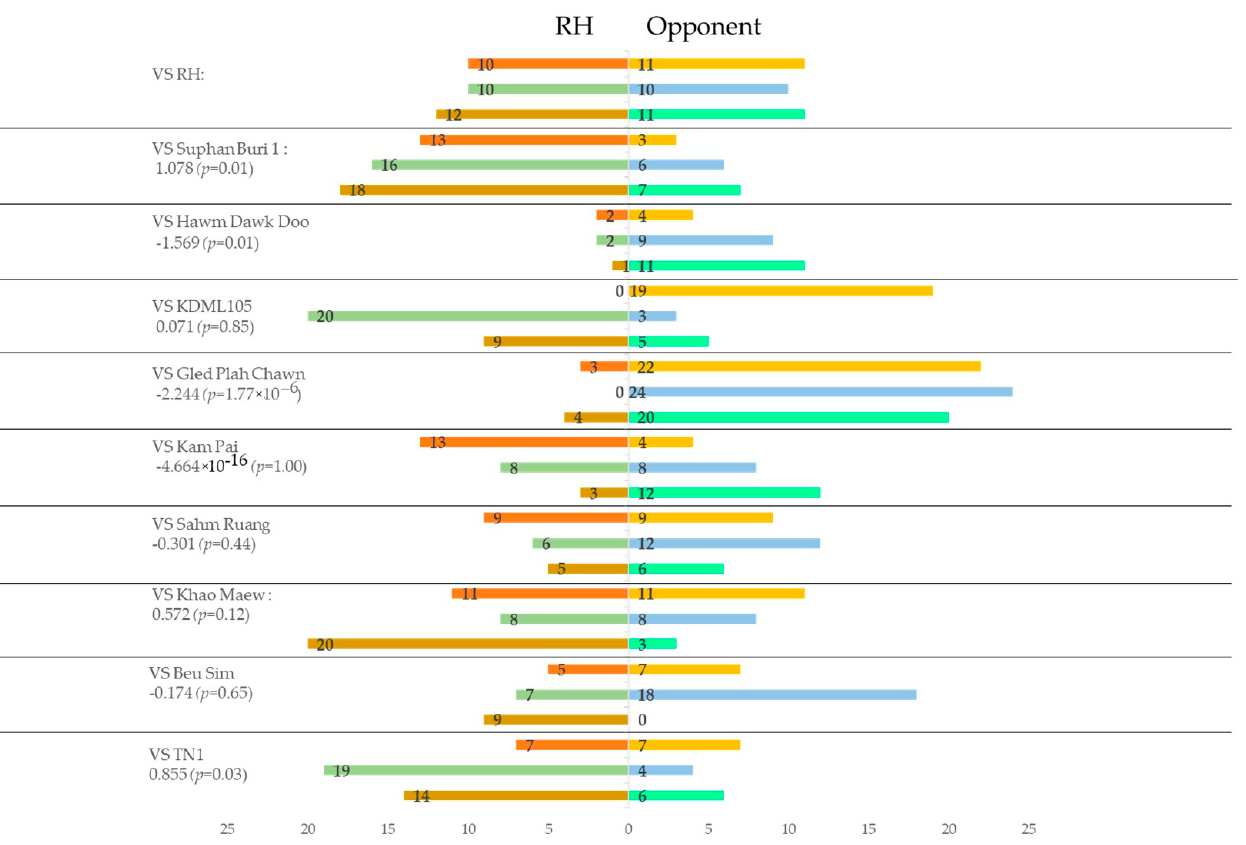
Figure 2. Relative olfactory preferences of BPH for volatiles from rice plants of RH variety to the others determined by two − choice tests using potted plants without BPH infestation.